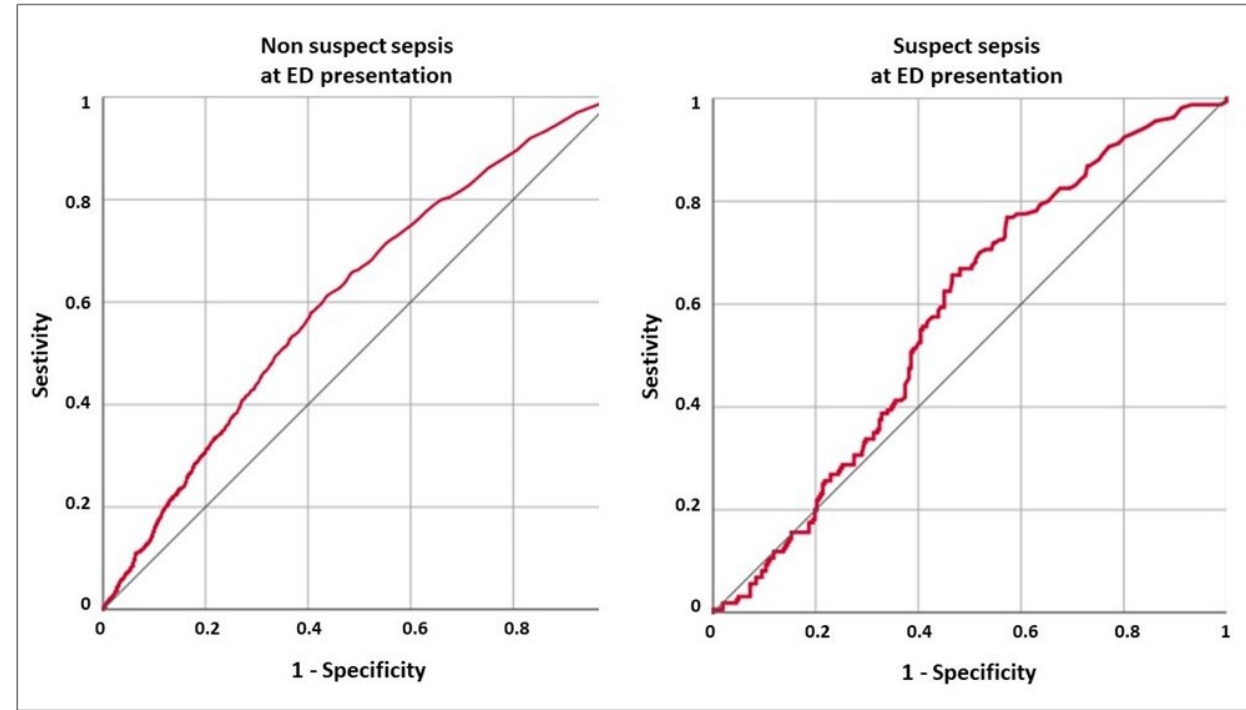
Figure 1. Graph of ROC curve analysis for PCT values in ED) for all-cause in-hospital death, both for non-suspected and suspected sepsis in ED (NSep and Sep groups). In the NSep group, the raising of PCT value was associated with a progressive increase in specificity. In the Sep patients, a low value of PCT had poor specificity and sensitivity for in-hospital death, and a specificity >80% was achieved only for PCT value >7.5 ng/mL.